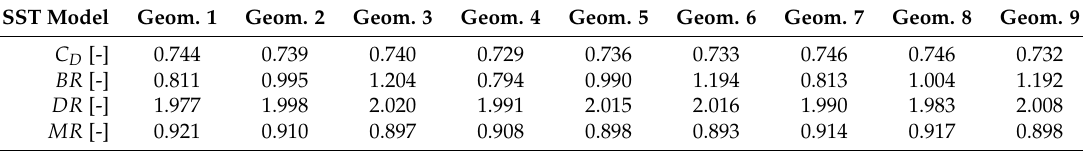
Table 2. Non-dimensional parameters for the film cooling configuration studied using the SST turbulence